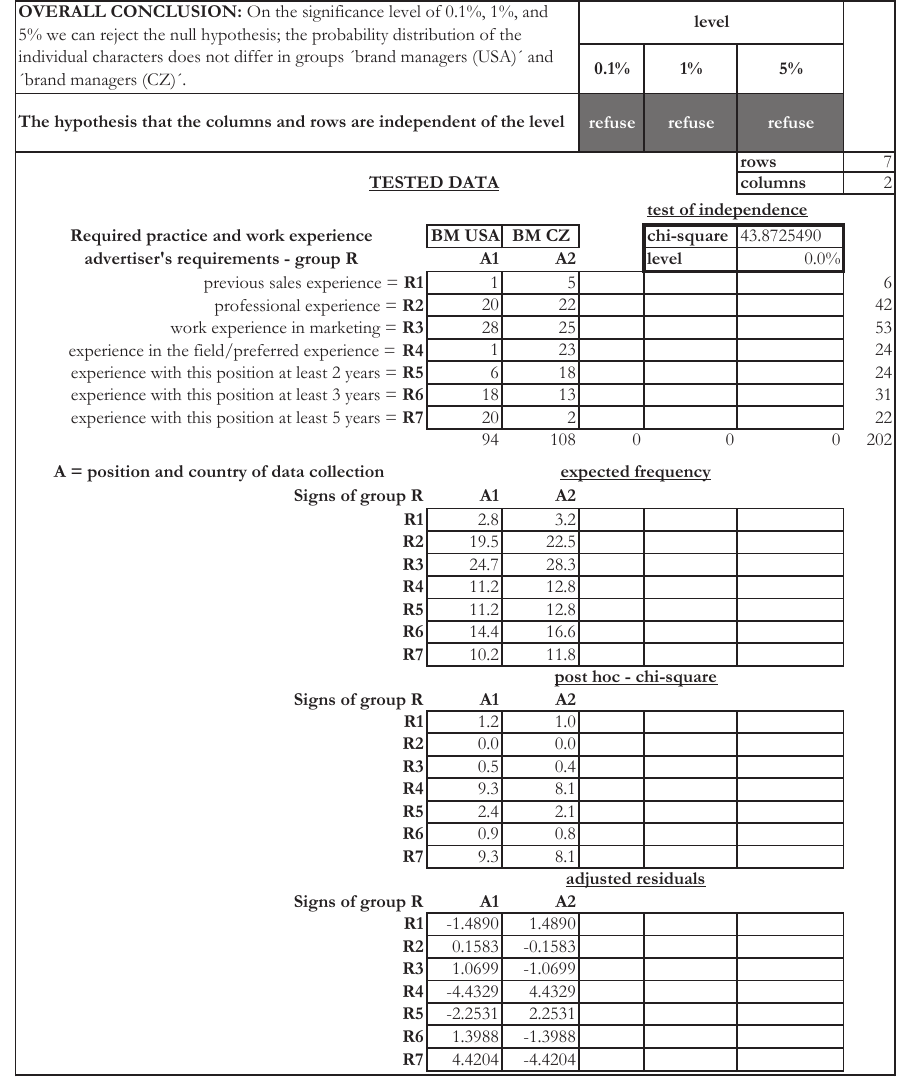
Tab. 3 – Two-dimensional analysis for a group of requirements for required practice and work experience. Source: Author´s independent